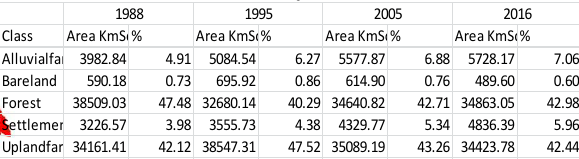
TABLE 1. Land use/cover area from 1988 to 2016 for central dry zone area of Myanmar.